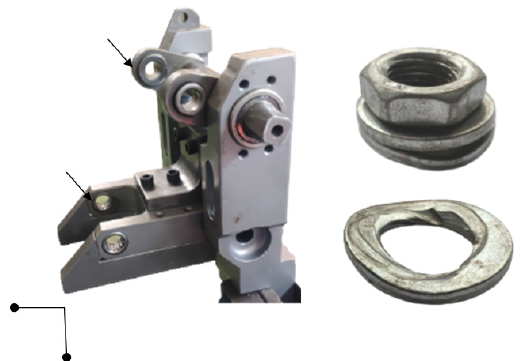
Figure 7. Extreme wear on the coupling system tunning slots.